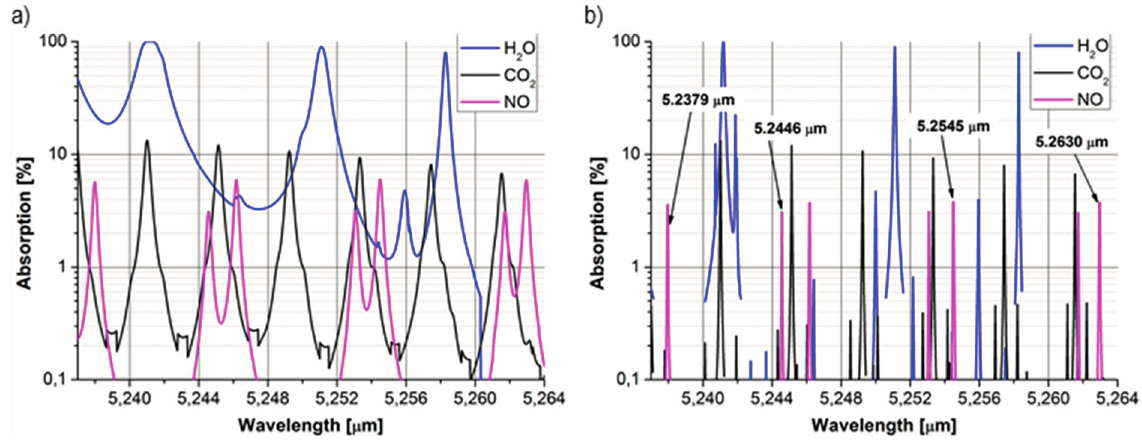
Figure 1. ( a ) The absorption of NO at pressures of 1 atm ( b ) and of 0.1 atm for concentrations occurring in human breath: NO—35 ppb, CO 2 —5%, H 2 O after the drying procedure—279